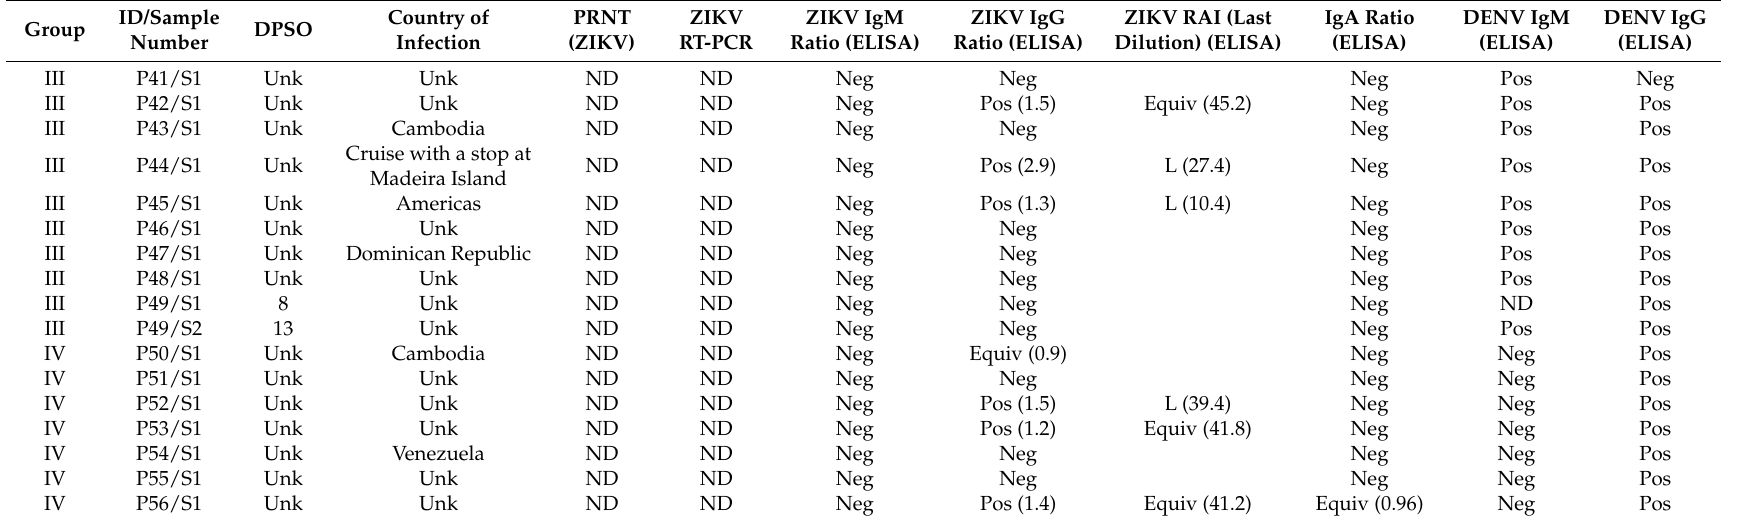
Table 3. PCR and serological results for patients with recent DENV infections (Group III) and with past DENV infections (Group